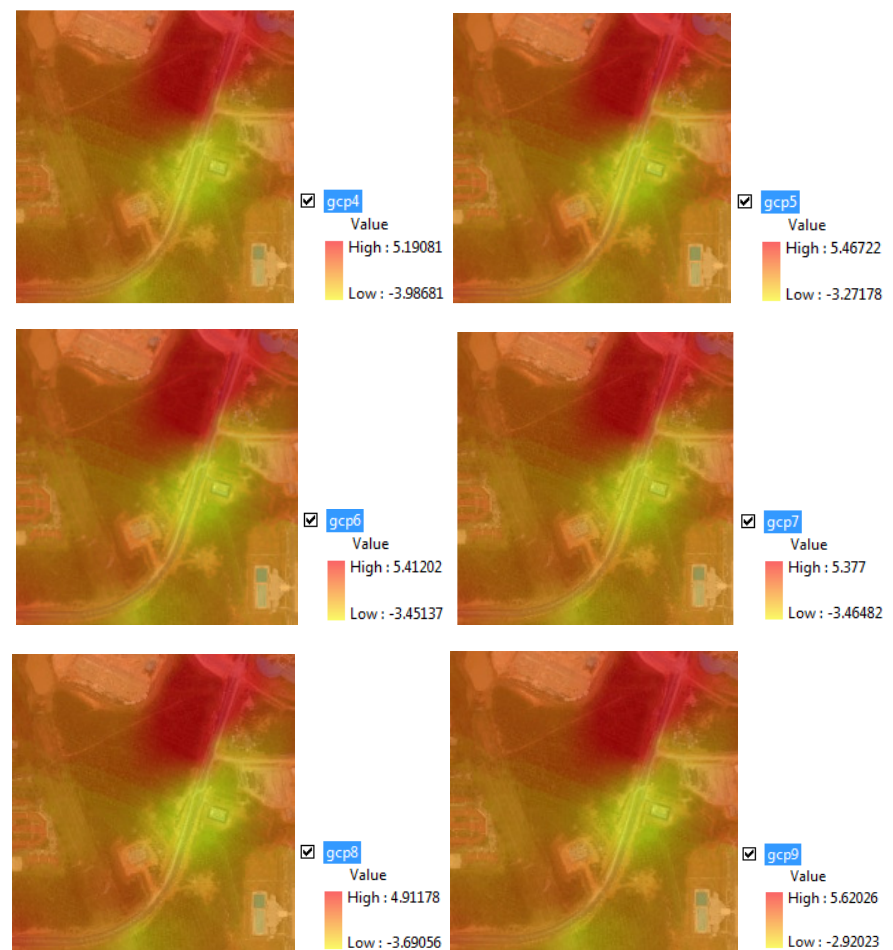
Figure 4. Results on Elevation Error for RTK GPS from Known GPS Station (2 minutes) based on different GCP